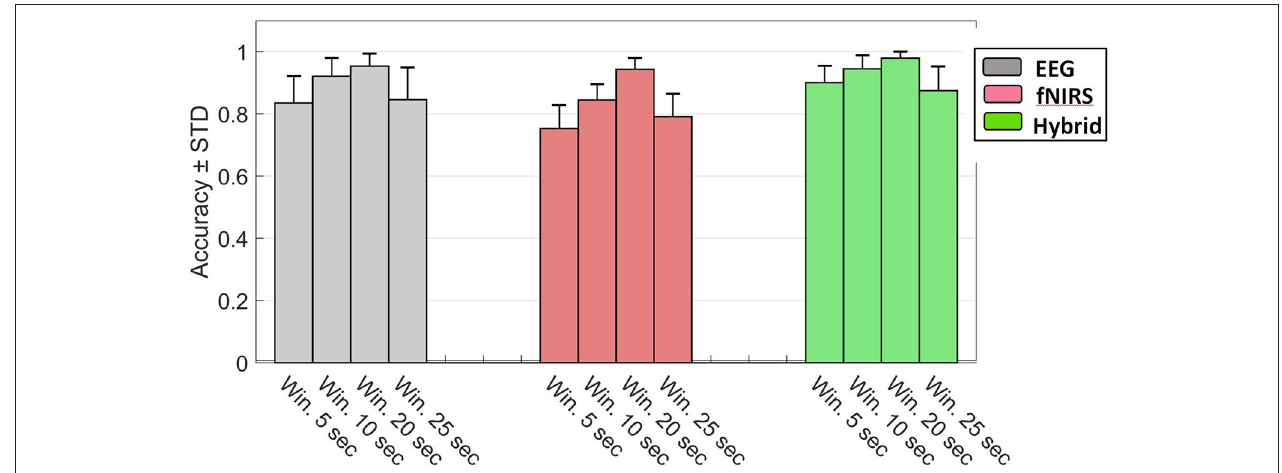
FIGURE 12 | Accuracy of the rest v 3-back classification as a function of window size for EEG (gray), fNIRS (red), and Hybrid (green) systems. Error bars indicate the standard deviation of inter-subject